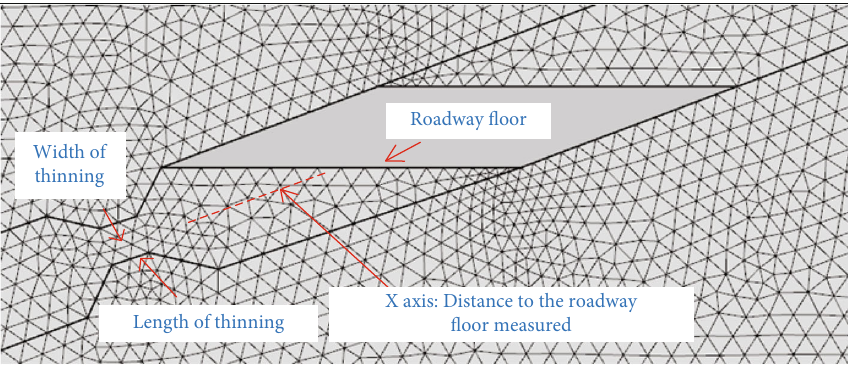
Figure 3: Enlarge region of the red rectangle from Figure 2.